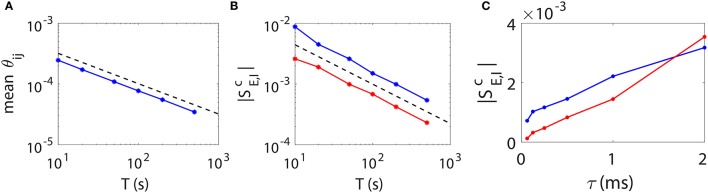
STR reconstruction accuracy as a function of data length T and sampling interval length τ. Here, we fix a random I&F network of 100 neurons (80 excitatory and 20 inhibitory) with connection probability 30% and use different data lengths or sampling interval lengths to examine the accuracy of the STR reconstruction. (A) θij averaged over all directions in the network as a function of data length T. Black dashed line indicates a T-12 scaling. (B)
|SEc| (red) and |SIc| (blue) as a function of data length T. Black dashed line indicates a T−0.65 scaling. (C)
|SEc| (red) and |SIc| (blue) as a function of τ. We fix τ = 0.5 ms in (A,B) and T = 100 s in (C).